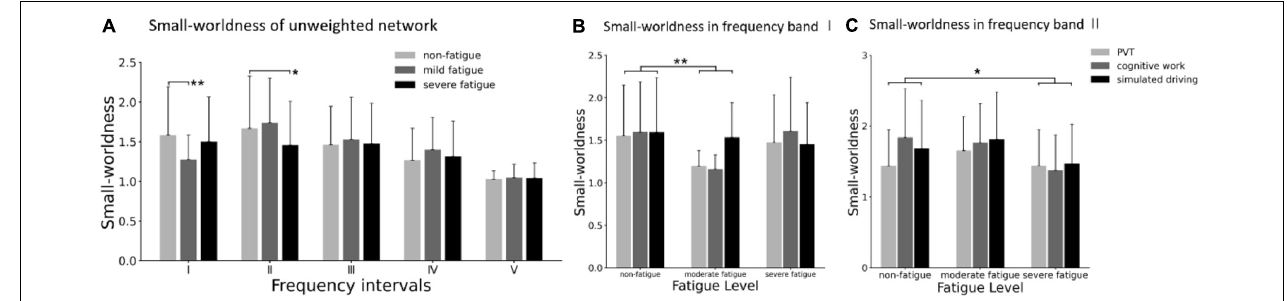
FIGURE 12 | (A) Comparison of small worldness in unweighted network of three fatigue levels in five frequency bands. (B) Results of post-hoc analyses of small worldness in unweighted network in frequency band I (0.005–0.021 Hz). (C) Results of post-hoc analyses of small worldness in unweighted network in frequency band II (0.021–0.052 Hz). Vertical bars are standard errors scores. * p < 0.05; ** p <